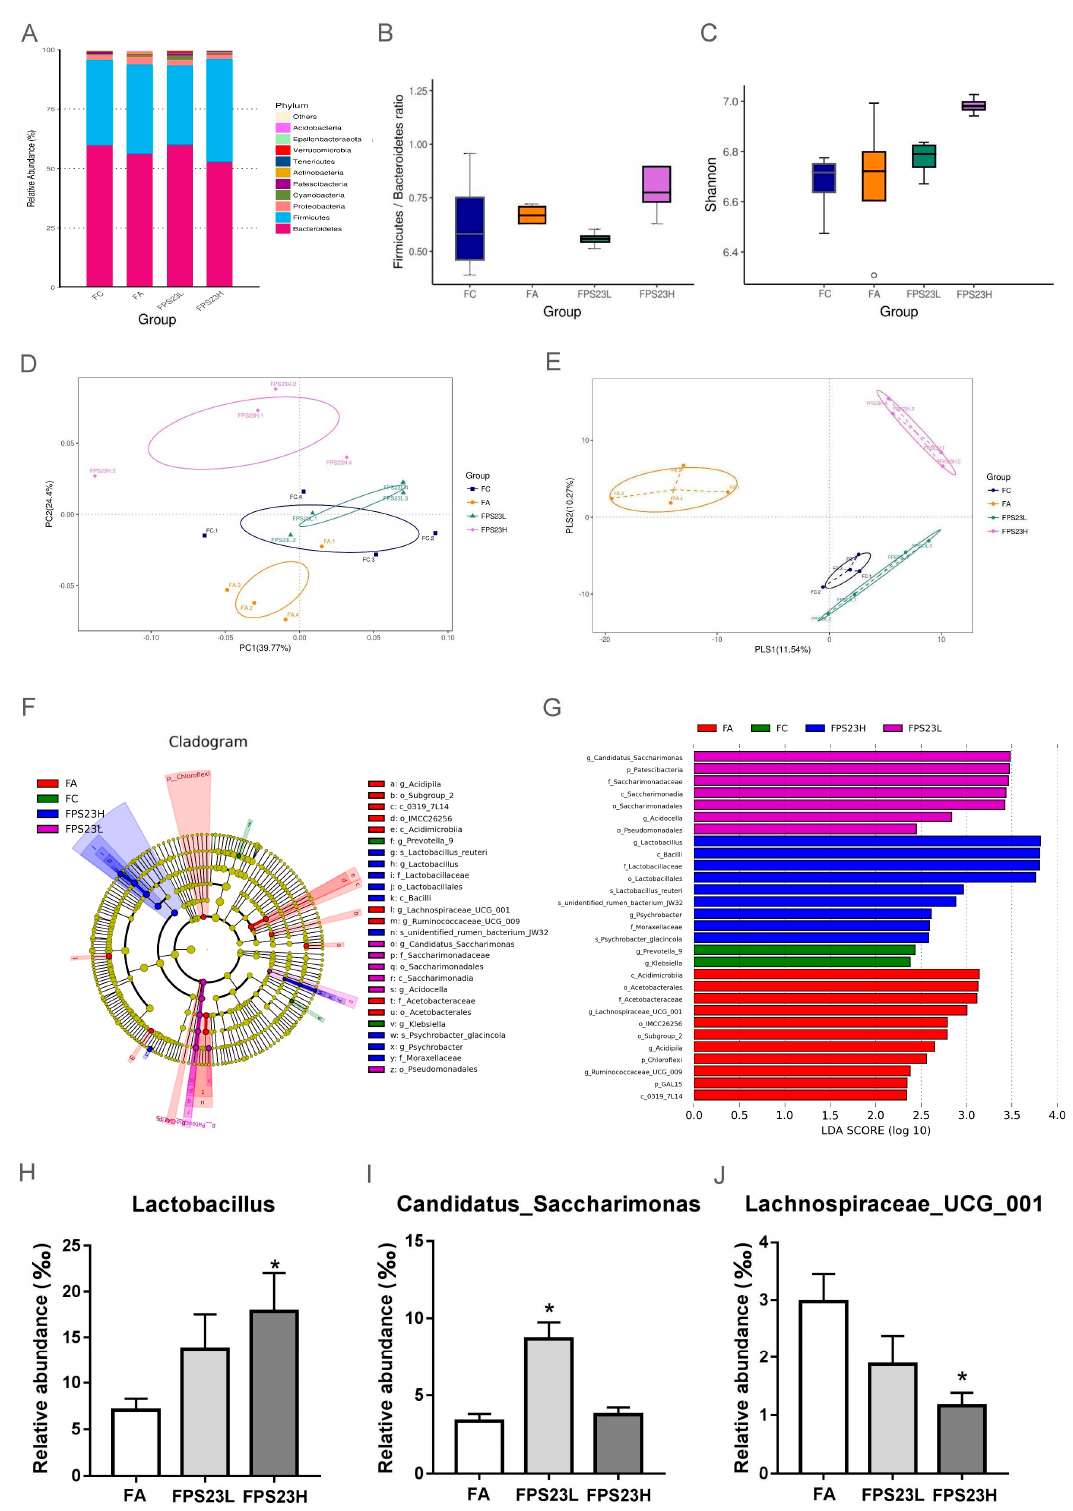
Figure 1. Gut microbiota composition. ( A ) Bacterial community distribution; ( B ) ratio of Firmicutes/Bacteroidetes; ( C ) alpha diversity indicated by Shannon’s diversity index; ( D , E ) beta diversity indicated by weighted principal co-ordinates analysis (PCoA) ( D ) and partial least squares discriminant analysis (PLS-DA) ( E ) in senescence accelerated mouse prone-8 (SAMP8) mice; ( F , G ) Linear discriminant analysis effect size (LEfSe) analysis of the gut microbiota of SAMP8 mice; ( H – J ) relative abundance of Lactobacillus ( H ), Candidatus_Saccharimonas ( I ), and Lachnospiraceae UCG 001 ( J ) in the aged SAMP8 mice. Asterisk (*) indicates significant differences from the female aged mice administered saline (FA) ( p < 0.05). n = 4.